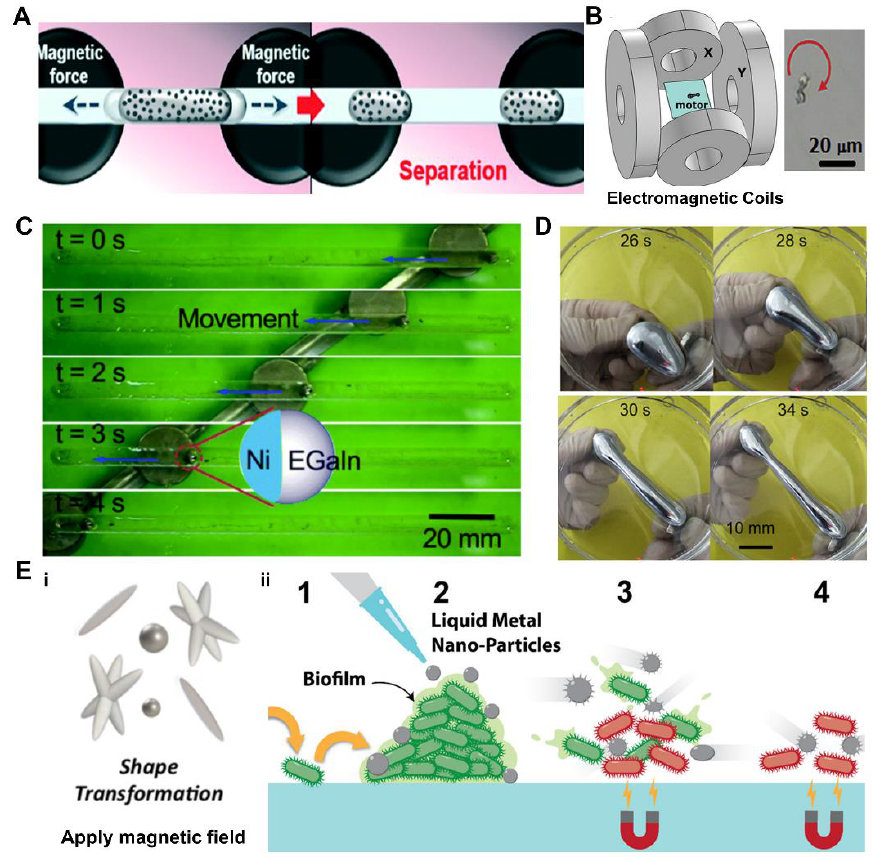
Figure 9. Magnetic field induced response. ( A ) Schematics depicting the separation of a liquid metal droplet in a microfluidic channel by magnetic-field-driven. Reprinted with permission from [140]. Copyright 2016, The Royal Society of Chemistry. ( B ) Schematic of magnetic liquid metal micromo- tors’ magnetic propulsion equipment (left) and time lapse photographs demonstrating the efficient rotation of a magnetic liquid metal micromotor (right). Reprinted with permission from ref. [141]. Copyright 2019, John Wiley and son. ( C ) The guidance of the Ni/EGaIn droplet by a magnet in a straight channel. Reprinted with permission from ref. [98]. Copyright 2016, The Royal Society of Chemistry. ( D ) The sequential snapshots of the stretching behavior of magnetic liquid metal under the magnetic manipulation in the horizontal level. Reprinted with permission from [111]. Copyright 2019, American Chemical Society. ( E ) (i). Shape transformation of magnetic liquid metal induced by magnetic field. (ii). Schematic representation of the physical action of the liquid metal-Fe particles causing bacterial cell death and reduction in the biofilm volume. Reprinted with permission from [142]. Copyright 2020, American Chemical Society.